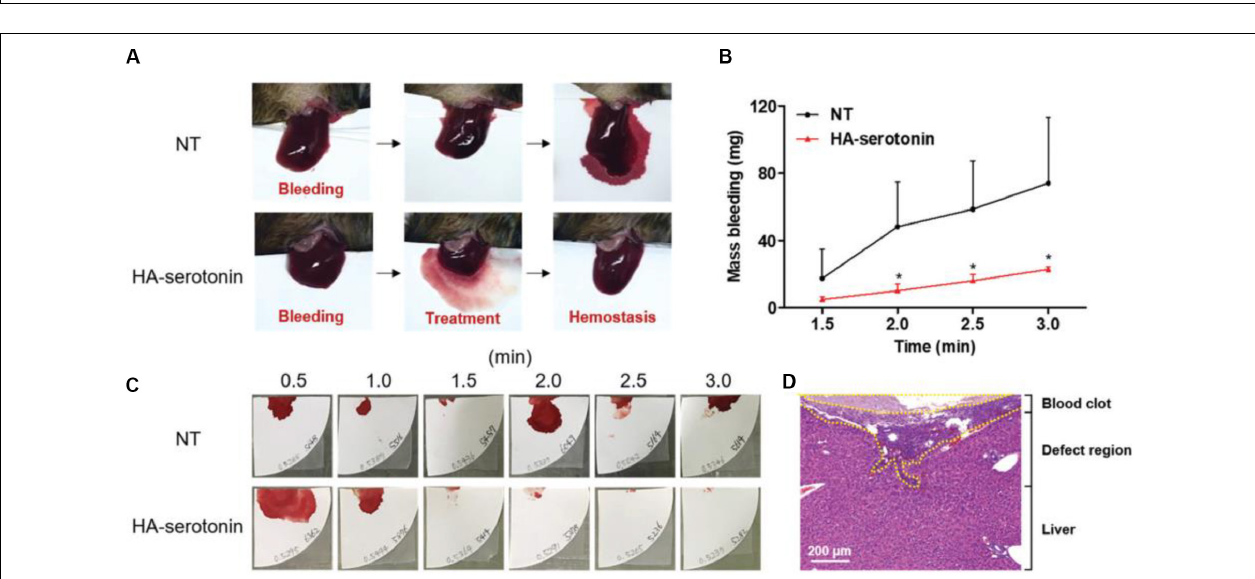
FIGURE 9 | . Preparation of TRAP-Sp with macroporous structures and reasonable mechanical properties. Reproduced with permission. Reproduced from Yang et al. (2019) with permission from Copyright 2019 Elsevier.